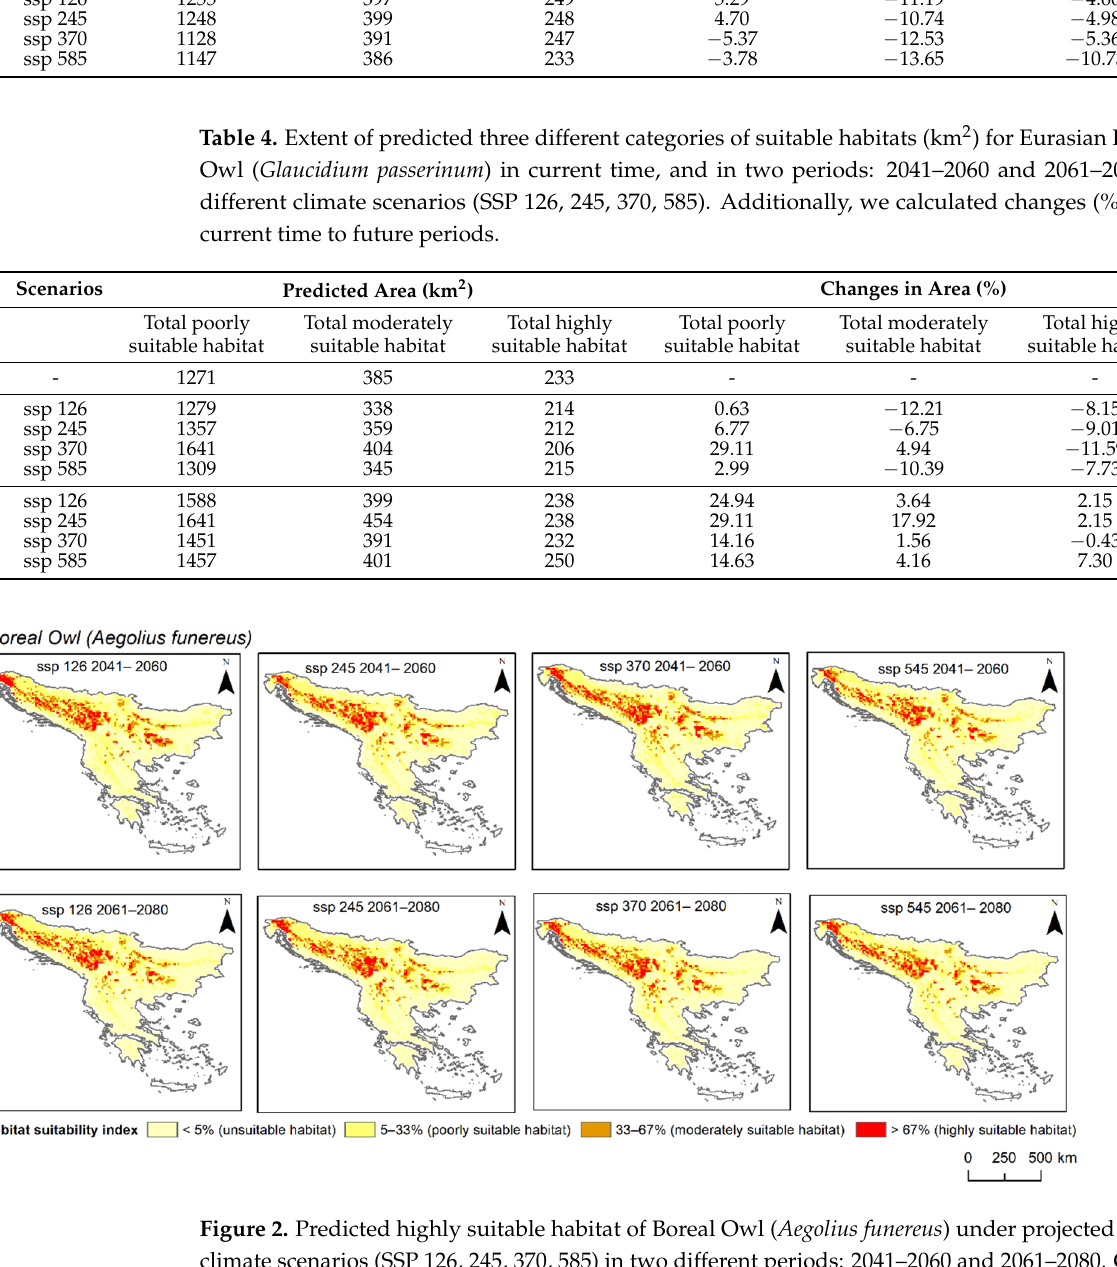
Table 7. Extent of two types of refugia (km2) for Eurasian Pygmy Owl ( Glaucidium passerinum ). Area